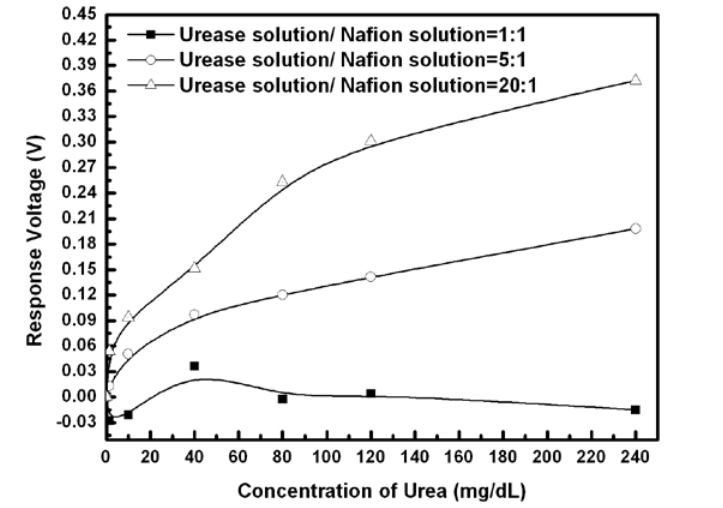
Figure 6. The urea responses of urease-EnFET with different ratio of urease entrapped dL in axis label.